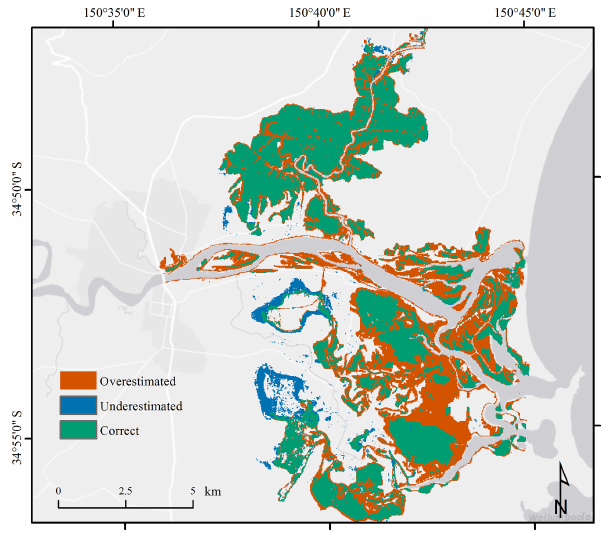
Figure 8. Map showing locations correctly estimated, underesti- mated and overestimated by the model in the lower Shoalhaven floodplain.